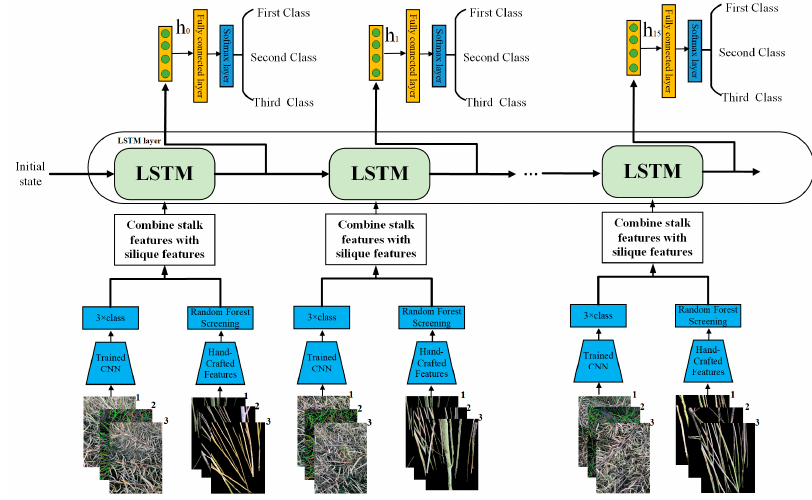
Figure 4. Structure of the prediction model using CNN-LSTM.